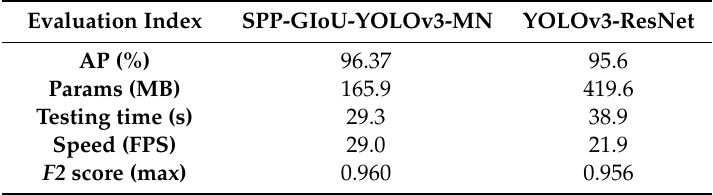
Table 8. Model comparison between SPP-GIoU-YOLOv3-MN (GIoU: Generalized Intersection over Union, MN: MobileNetv2) and YOLOv3-ResNet.